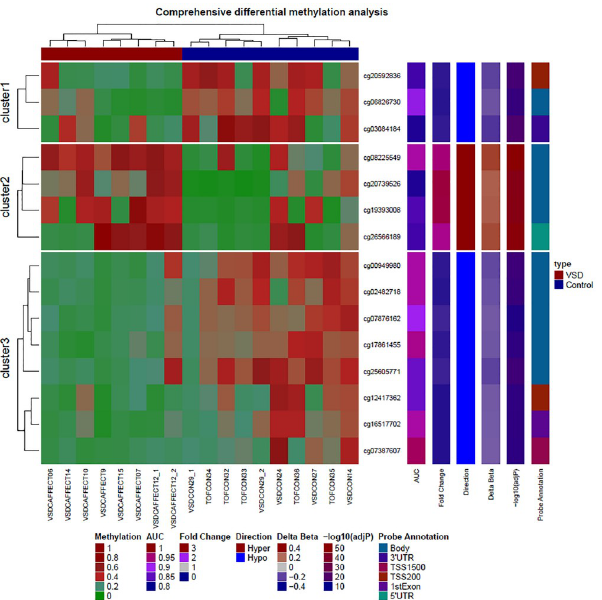
Fig 1. Heatmap of 15 highly differentially methylated loci. Unsupervised hierarchical clustering of differentially methylated loci (rows) in 8 affected and 10 control samples (columns). These 15 CpG loci are at least either 2.0-fold hypomethylated or 2.0-fold hypermethylated with False Detection Rate < 0.00001 in the disease (VSD) condition (red colored squares) compared to normal subjects (blue colored squares). The figure also displays direction, fold change in disease, probe relationship and probe annotation of differentially methylated CpG sites. The red color in the heatmap indicates hyper- DNA-methylation and blue, hypo-DNA-methylation values.